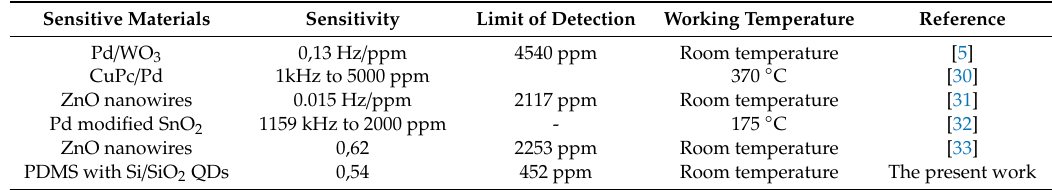
Table 3. Comparison of the results obtained in the literature for other SAW hydrogen